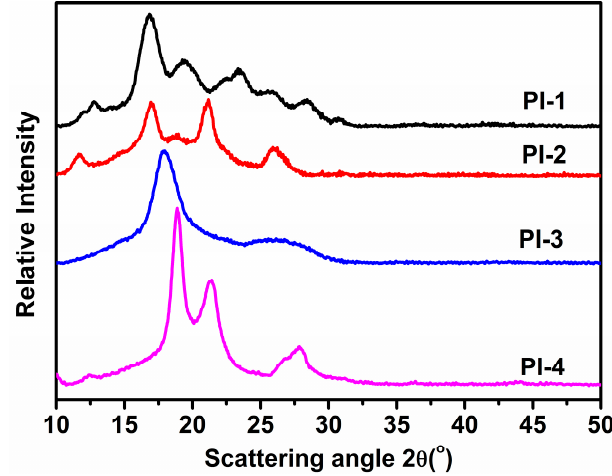
Figure 2. Wide-angle X-ray diffraction (WAXD) patterns of polyimide powders.